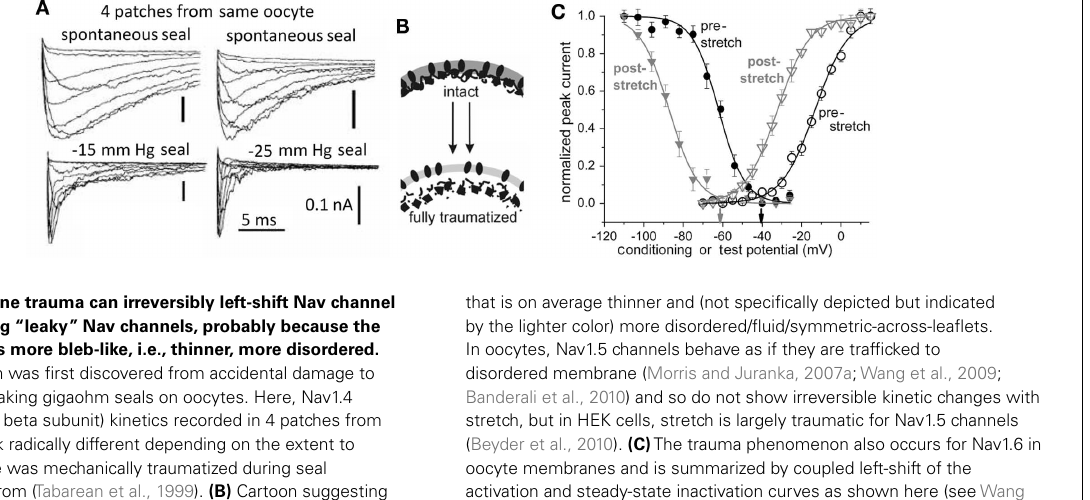
FIGURE 4 | Membrane trauma can irreversibly left-shift Nav channel operation, producing “leaky” Nav channels, probably because the resident bilayer gets more bleb-like, i.e., thinner, more disordered. (A) This phenomenon was first discovered from accidental damage to membranes while making gigaohm seals on oocytes. Here, Nav1.4 (without the auxiliary beta subunit) kinetics recorded in 4 patches from the same oocyte look radically different depending on the extent to which the membrane was mechanically traumatized during seal formation. Modifed from (Tabarean et al., 1999). (B) Cartoon suggesting that bleb formation leaves channels (dark ovals) in a bilayer environment